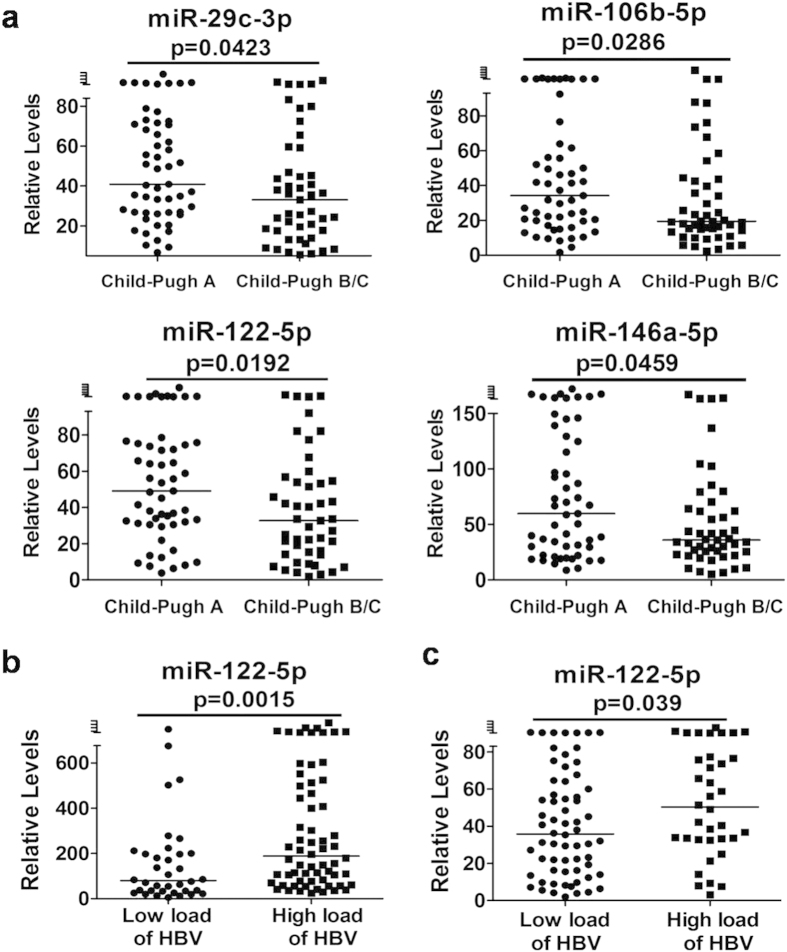
Comparison of miRNAs in different status of CHB and LC patients.(a) 4 miRNAs, miR-29c-3p, miR-106b-5p, miR-122-5p and miR-146a-5p were significantly upregulated in Child-Pugh A LC patients (p < 0.05) compared with Child-Pugh B/C LC patients. (b,c) According to serum levels of HBV load, CHB patients and LC patients were separated into 2 groups, miR-122-5p was considerably up-regulated in CHB (p = 0.0015, b) or LC (p = 0.039, c) patients with high viral load than with low viral load. Y axis represents relative expression levels of each miRNA in the corresponding subjects. P values were calculated using the Mann-Whitney test and p < 0.05 was significant.